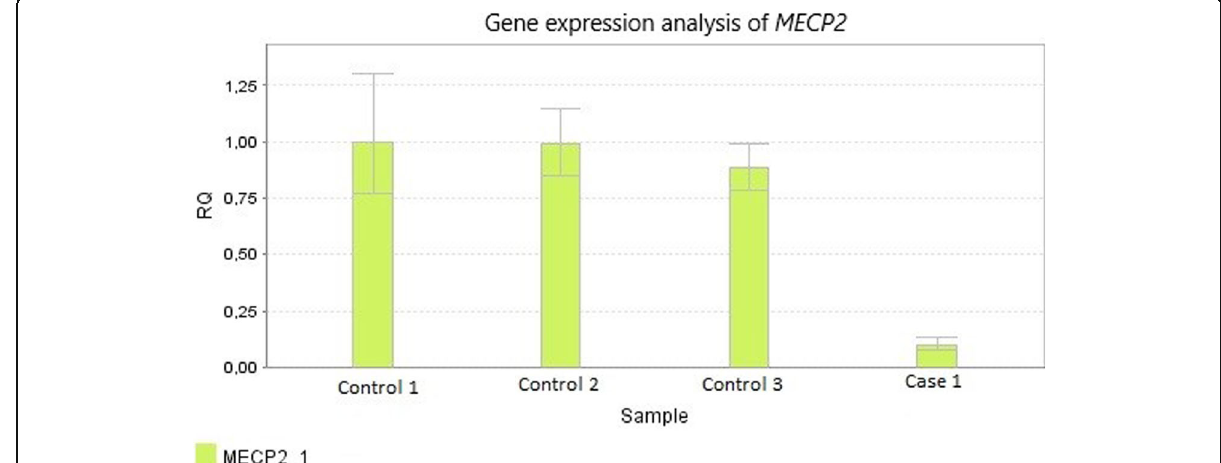
Fig. 2 The relative expression level of MECP2 (the alternative transcripts coding for isoforms MeCP2_E1) in cultured fibroblasts of three female controls and Case 1. The MECP2 gene expression analysis was performed on mRNA isolated from her fibroblasts, using Applied Biosystems 7500 Fast Real-Time PCR System (ABI, Foster City, CA), with pre-designed assay (TaqMan MGB probe HS01598237). GAPDH served as an endogenous control. The RQmin and RQmax with the confidence interval set at 95%:Female1; RQ Min 0.77, RQ Max 1.29, Female2; RQ Min 0.85, RQ Max 1.14, Female3; RQ Min 0.787, RQ Max 0,99, Patient; RQ Min 0.07, RQ Max